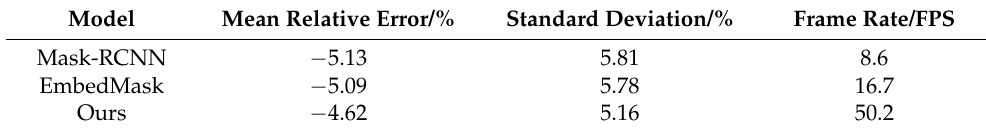
Table 4. Model Performance Comparison.